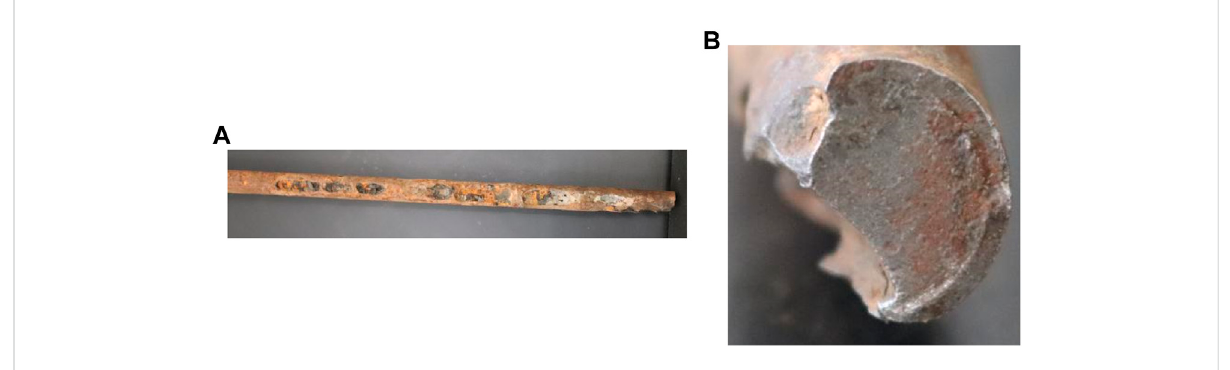
FIGURE 2 Fatigue cross-sectional shape of the pumping